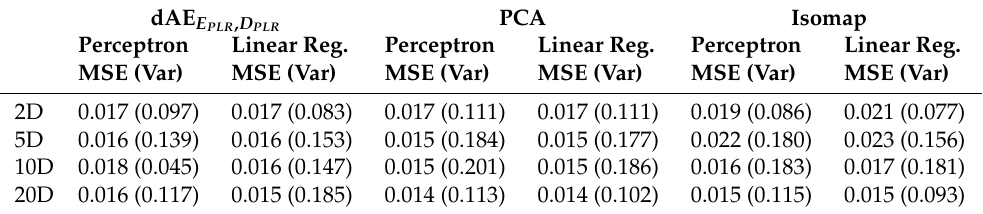
Table 5. Performance of the Hard model.MSE and Variance values are rounded to the third digit after the decimal sign. dAE E PLR , D PLR